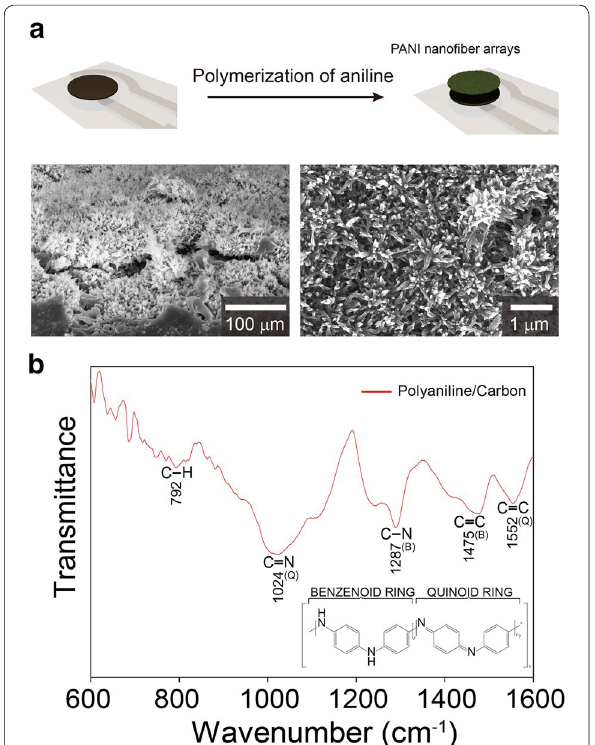
Fig. 2 a SEM images of PANI nanofiber arrays on pH sensor with schematic illustration of PANI polymerization procedure. b FT-IR spectrum of PANI coated on carbon electrode Fig. 3 a EMF responses of pH sensor measured in buffered